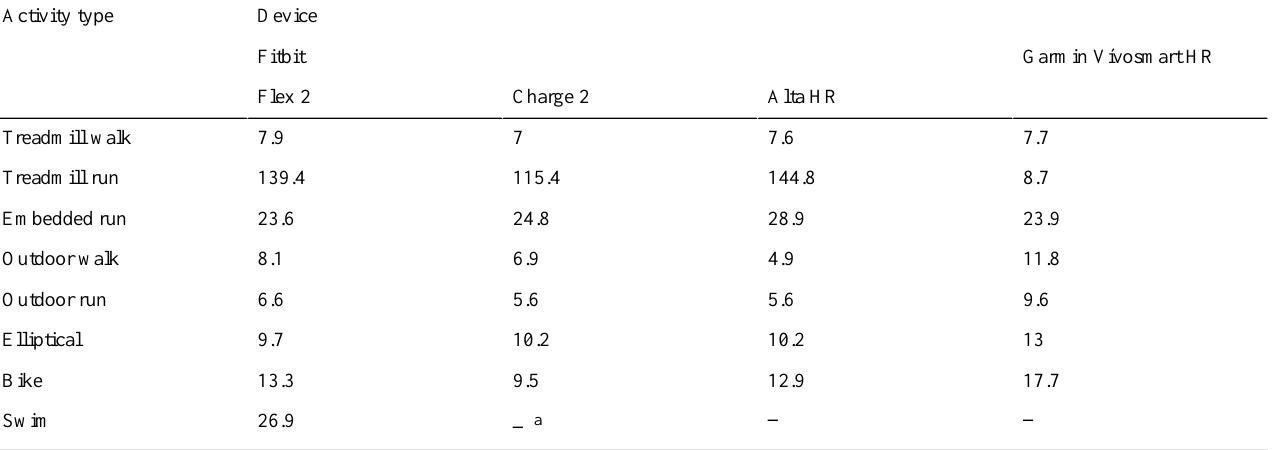
Table 3. Mean absolute percent error of duration measures by device and activity.